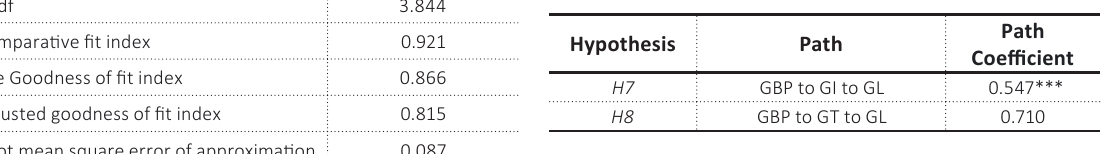
Table 6. Mediation result